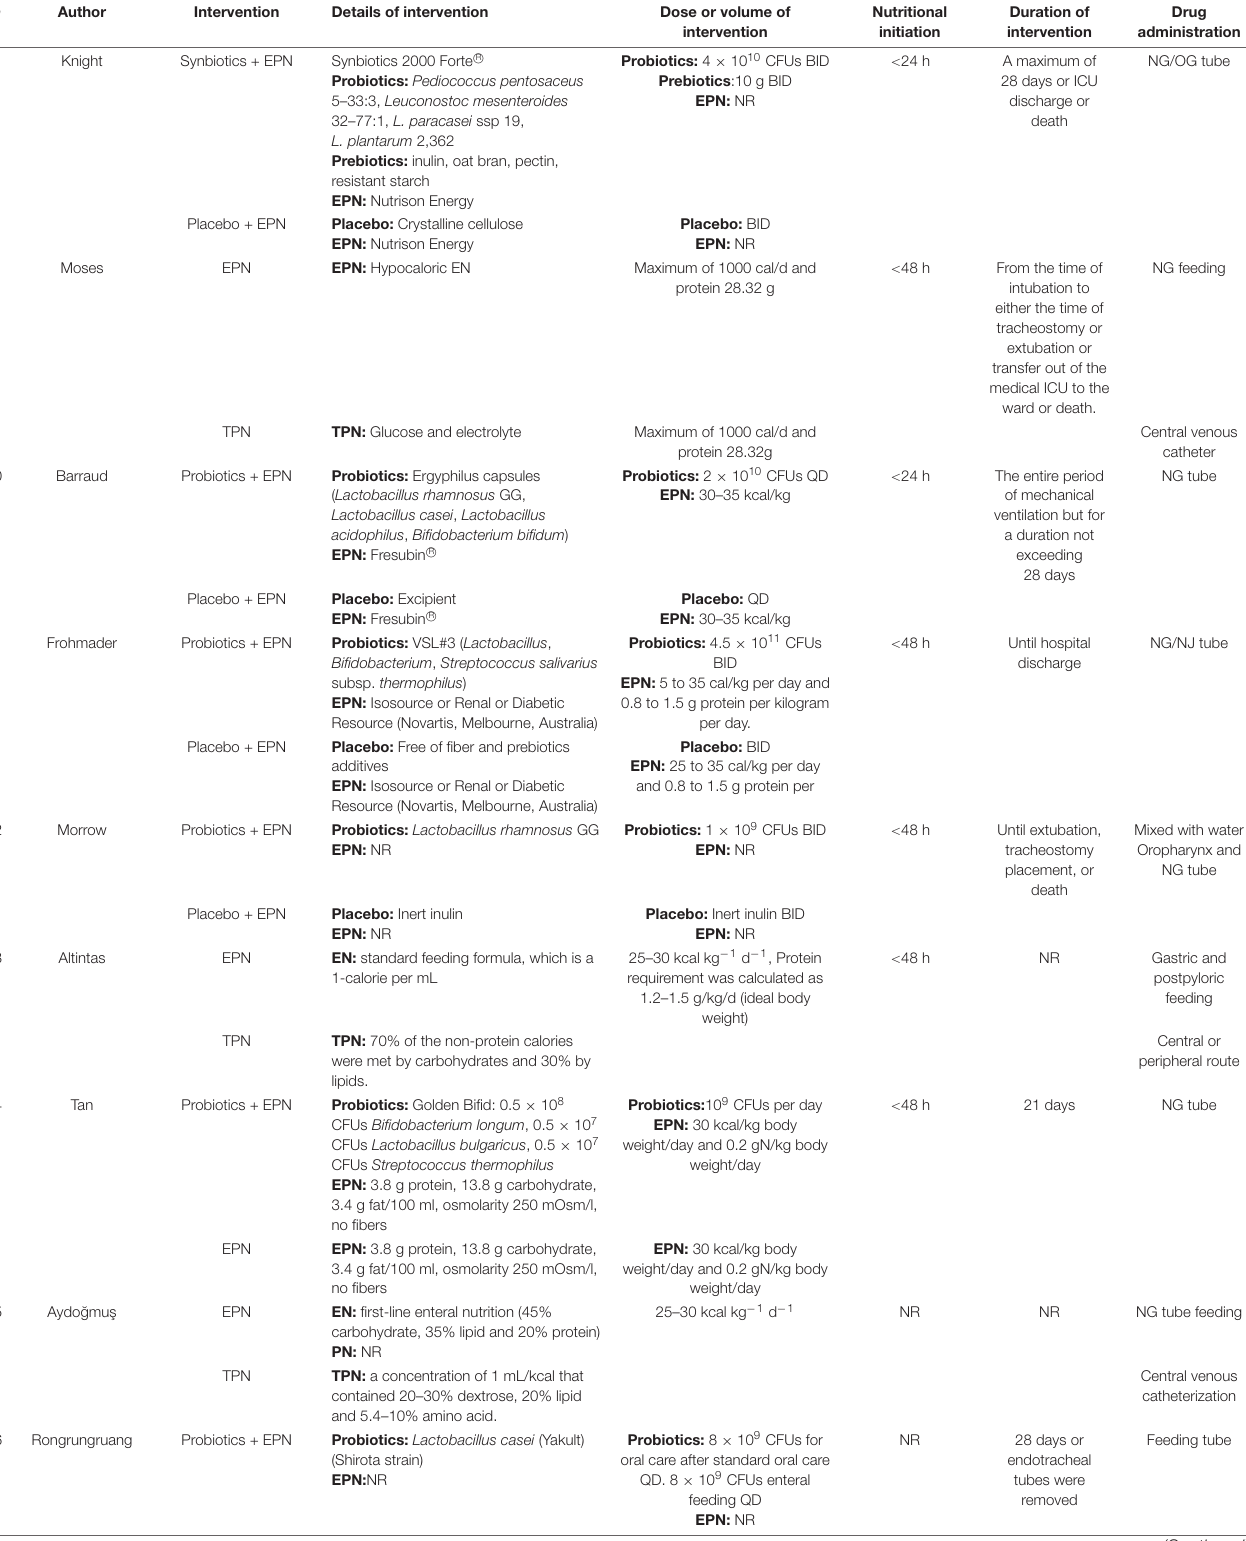
tubes were removed